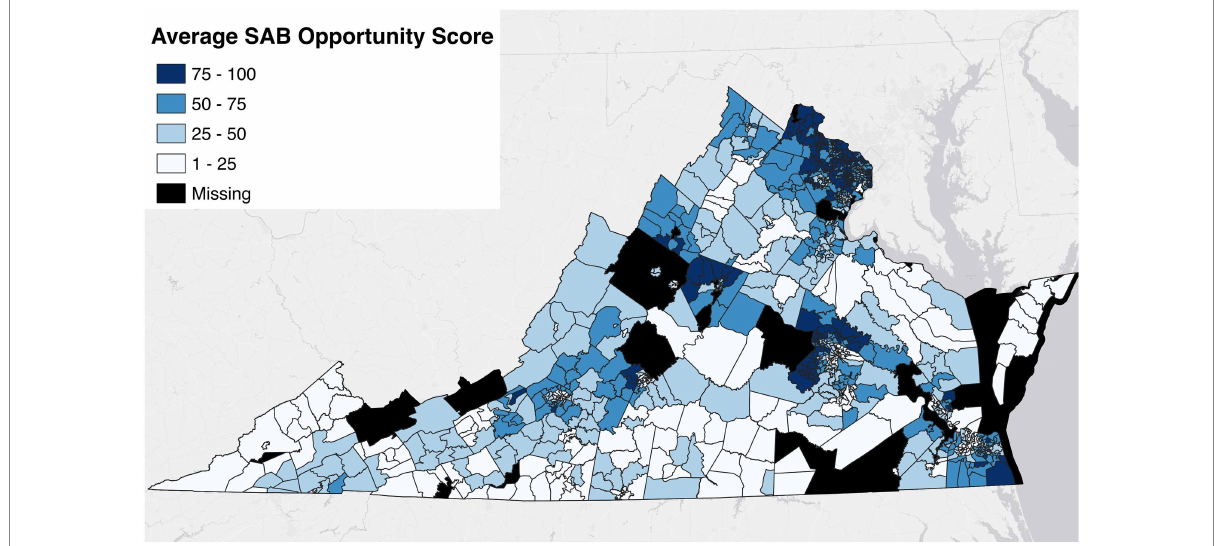
FIGURE 2 Weighted average COI score, by 2015 Virginia school attendance